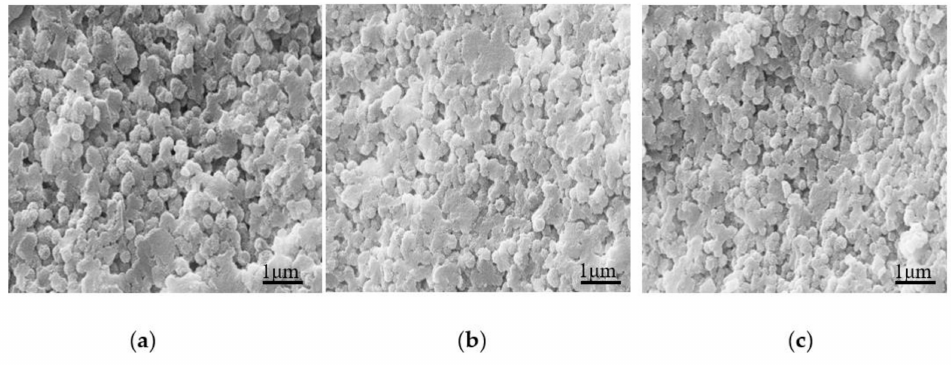
Figure 9. SEM comparison of UF resin with a molar ratio of 1.0 cured under different NH 4 Cl additions. ( a ) 1%, ( b ) 3%, ( c ) 8%.